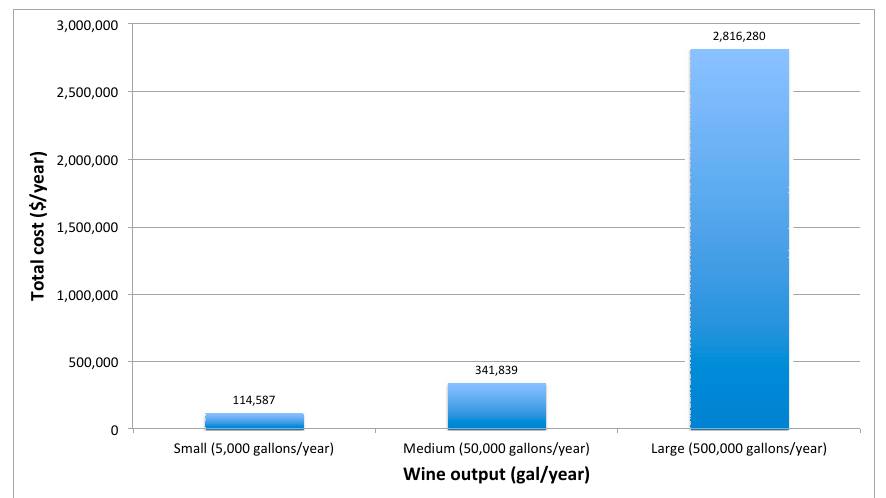
* All values were calculated based on the data provided in Table 4.